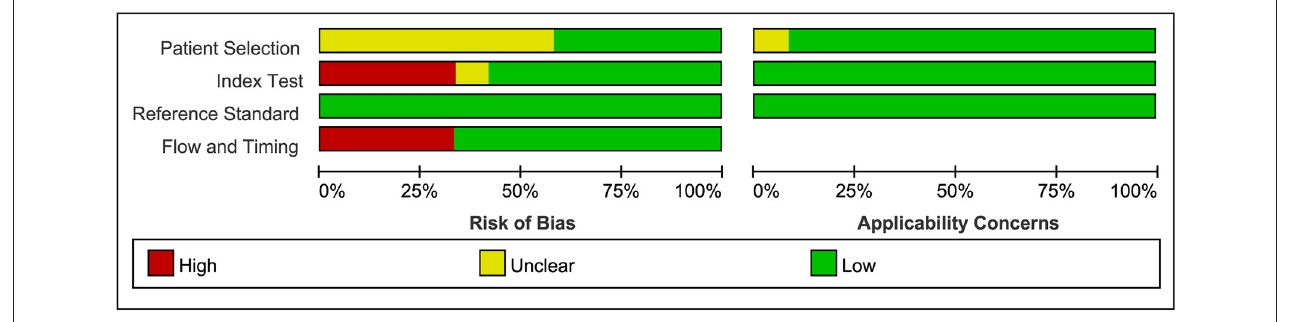
FIGURE 2 | Bar chart of literature quality